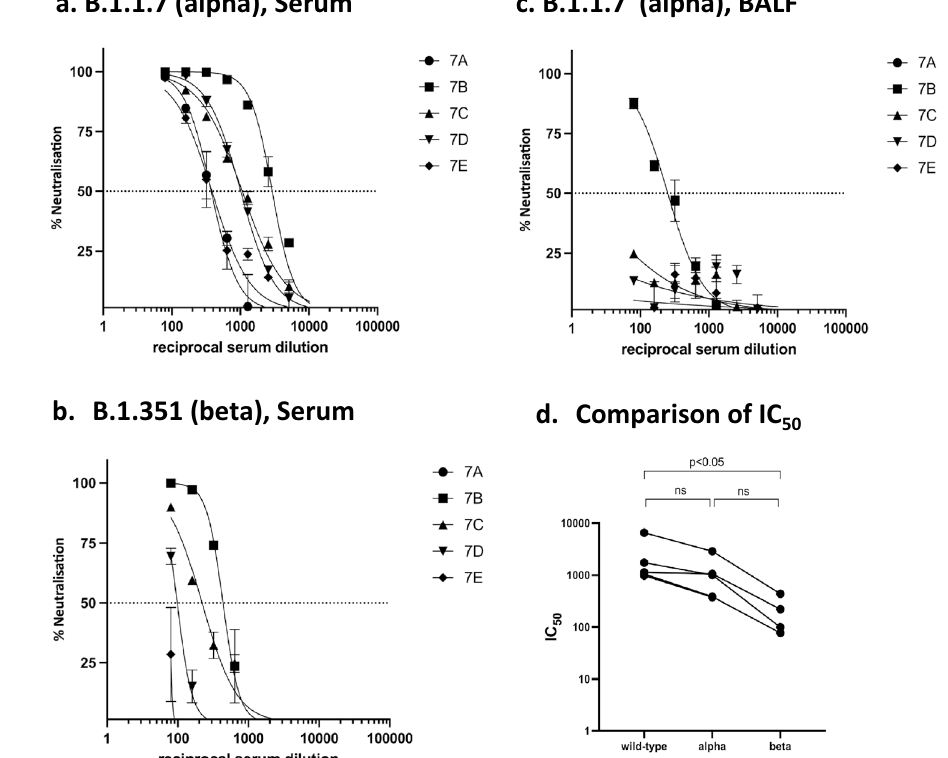
Figure 4. Monovalent SARS-CoV-2 RBD-cCPE vaccine induces neutralizing antibodies against SARS-CoV-2 pseudotypes B.1.1.7 and B.1.351. Mice were prime-boost immunized (d0, d21) intranasally with M-cell targeted RBD (RBD-cCPE, group #7), and sera and BALF obtained on day 28, 1 week after the boost, diluted in tenfold steps, were assayed for neutralization of pseudotype viruses. The spike protein sequence was derived from SARS-CoV-2 strain Wuhan-Hu-1, strain B.1.1.7 (Alpha), or B.1.351 (Beta). ( a , b ) Serum neutralization. ( c ) BALF neutralization. ( d ) Comparison of serum neutralization of SARS-CoV-2-PV wildtype (Wuhan-Hu-1), alpha, and beta variants. Statistical analysis (Mann–Whitney U test).